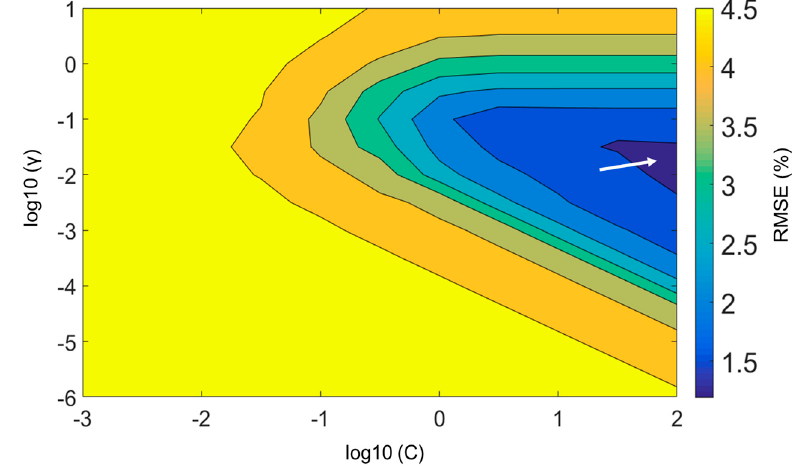
Figure 7. Counter-plot example obtained from the grid-searching method for optimizing the support-vector regression (SVR) parameters. The arrow indicates a finer grid with the lowest RMSE with the highest prediction.